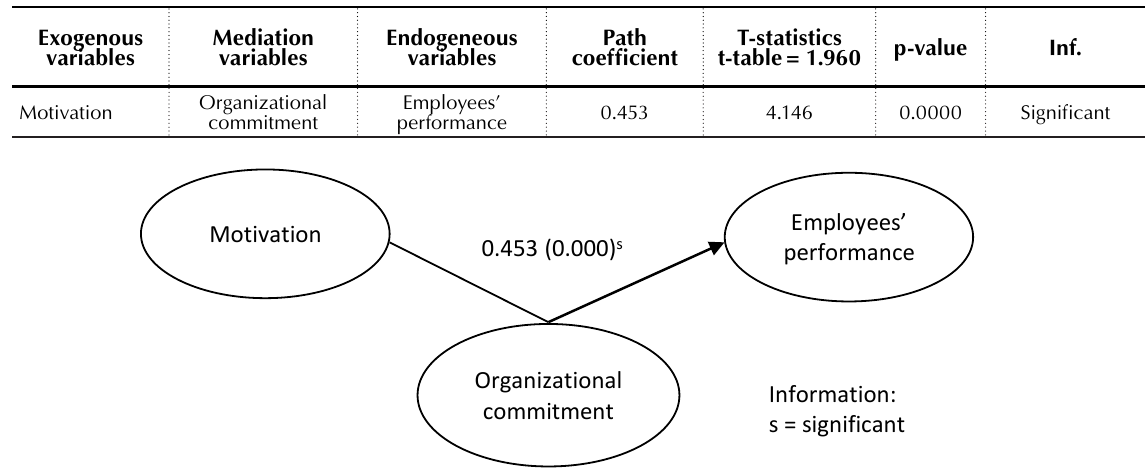
Figure 2. Diagram of indirect effect hypothesis test